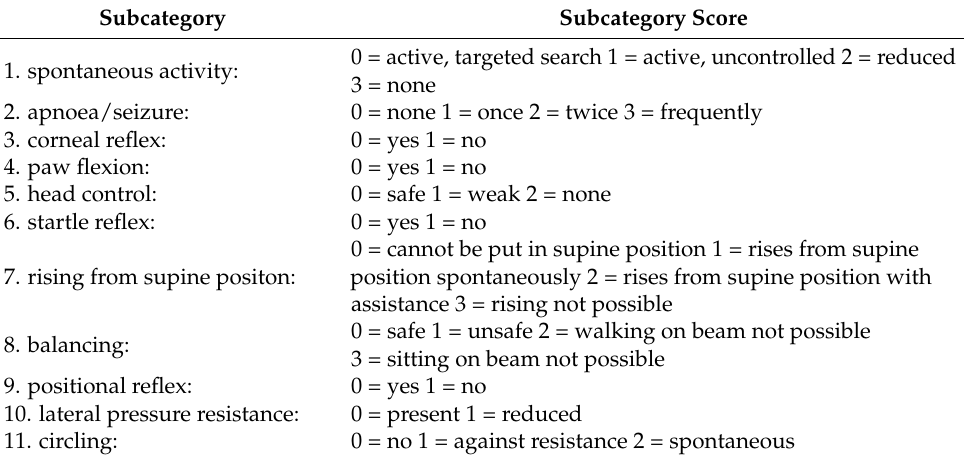
Table 1. A modified Dixon’s and Bederson’s score was used to evaluate neurological functionality 24 h after CCI. The sum of all subcategories yielded the final score.